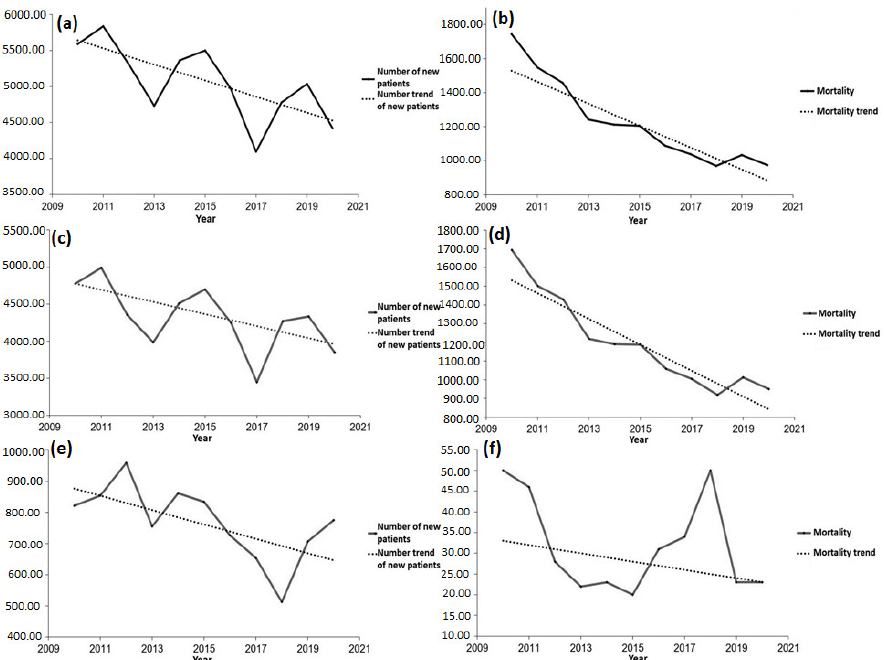
Figure 20. Results of the trends in the number of new patients and patients who died from cardiovascular diseases during the period 2010 to 2020: ( a ) overview of the number of new patients with acute coronary syndrome along with the trend line of the disease, ( b ) overview of the number of patients who died from acute coronary syndrome with the mortality trend, ( c ) overview of the number of new patients with myocardial infarction along with the trend in the number of new patients, ( d ) overview of the number of patients who died from myocardial infarction and the mortality trend, ( e ) overview of the number of new patients with unstable angina pectoris with the trend line of new patients, and ( f ) overview of the number of patients who died from unstable angina pectoris with the mortality trend